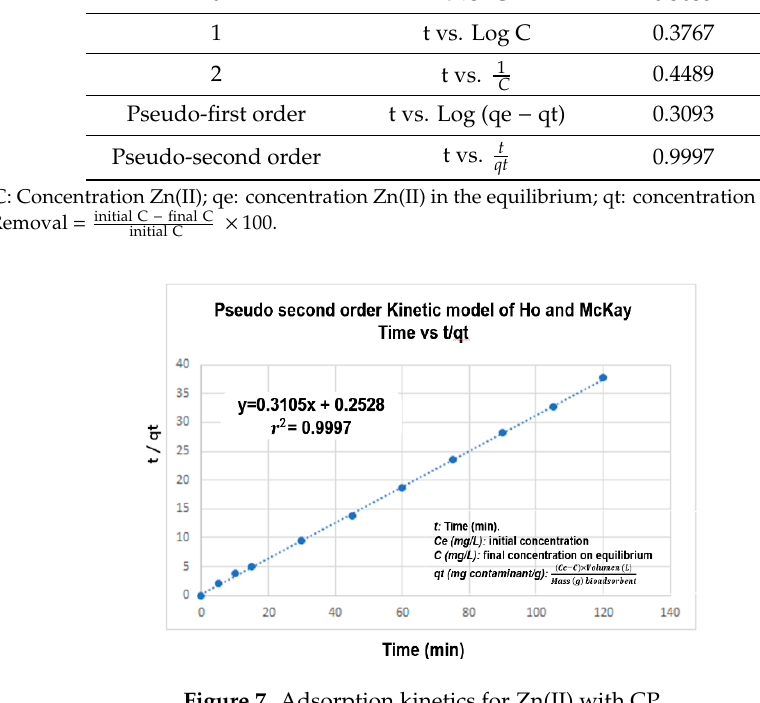
Table 2. Kinetic orders applied to the biosorption process, r 2 , and kinetic parameters.